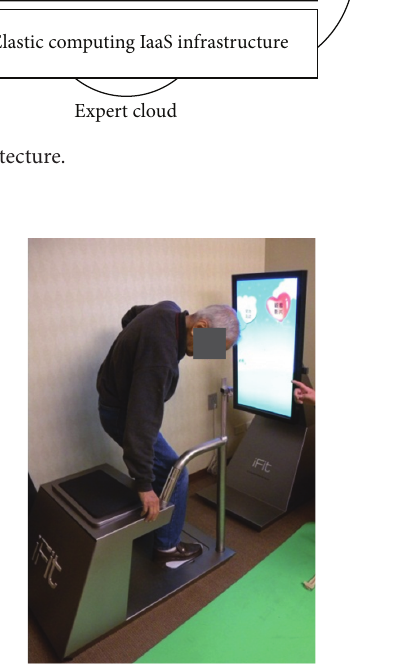
Figure 2: The iFit for physical fitness measurement and